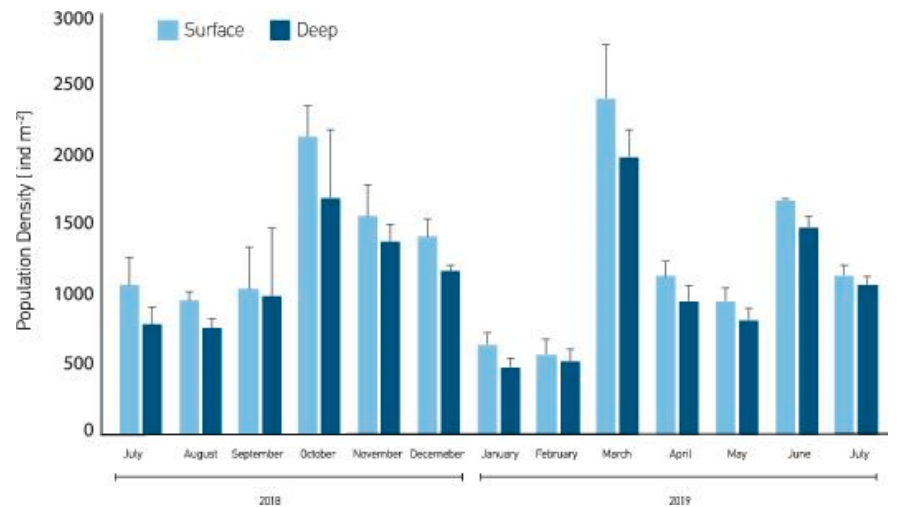
Figure 4. Temporal variation of the surface and deep population density of Caprella scaura from a fish farm in the Pagasitikos Gulf. Bars indicate standard deviation.